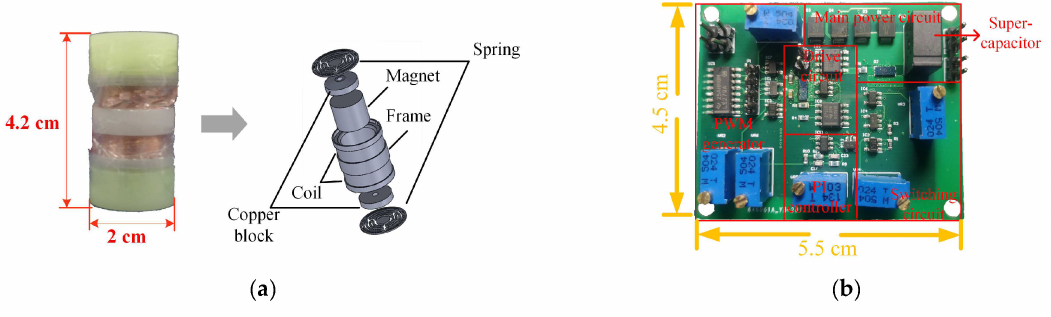
Figure 14. ( a ) The EVEH module used in the system [22]; ( b ) the prototype of the designed dual-mode hybrid step-up